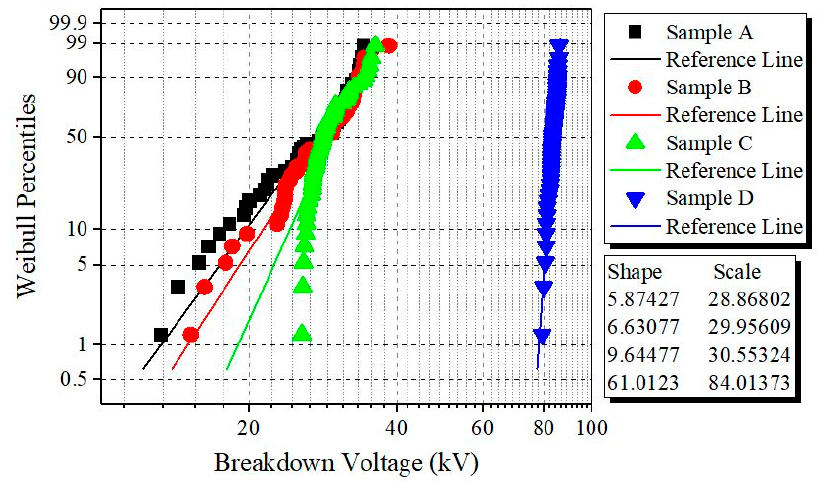
Figure 9. Weibull distribution results of fifty breakdown voltage data at various sample method preparations. Table 4. Probability of 1%, 50% and 90% breakdown voltage values of various oil samples with different treatments.